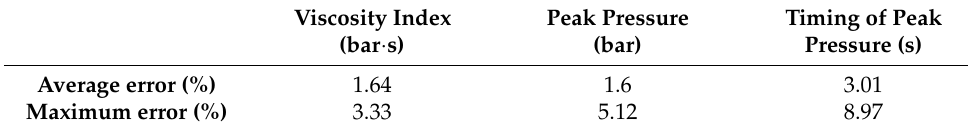
Figure 19. Prediction results of timing of peak pressure. Table 3. Error of prediction results. Viscosity Index (bar·s)